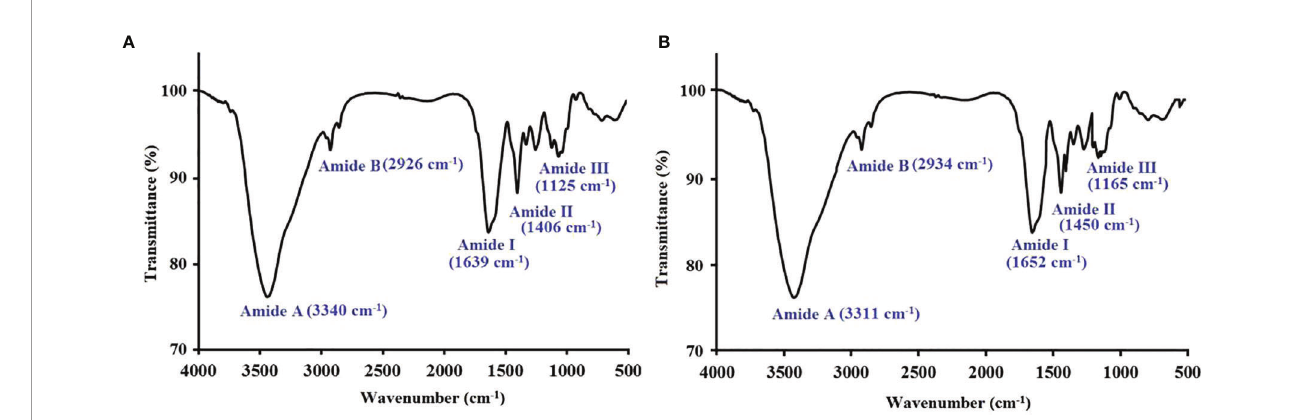
FIGURE 4 | FTIR spectra of cartilage gelatin (A) from Siberian sturgeon and pigskin gelatin (B)